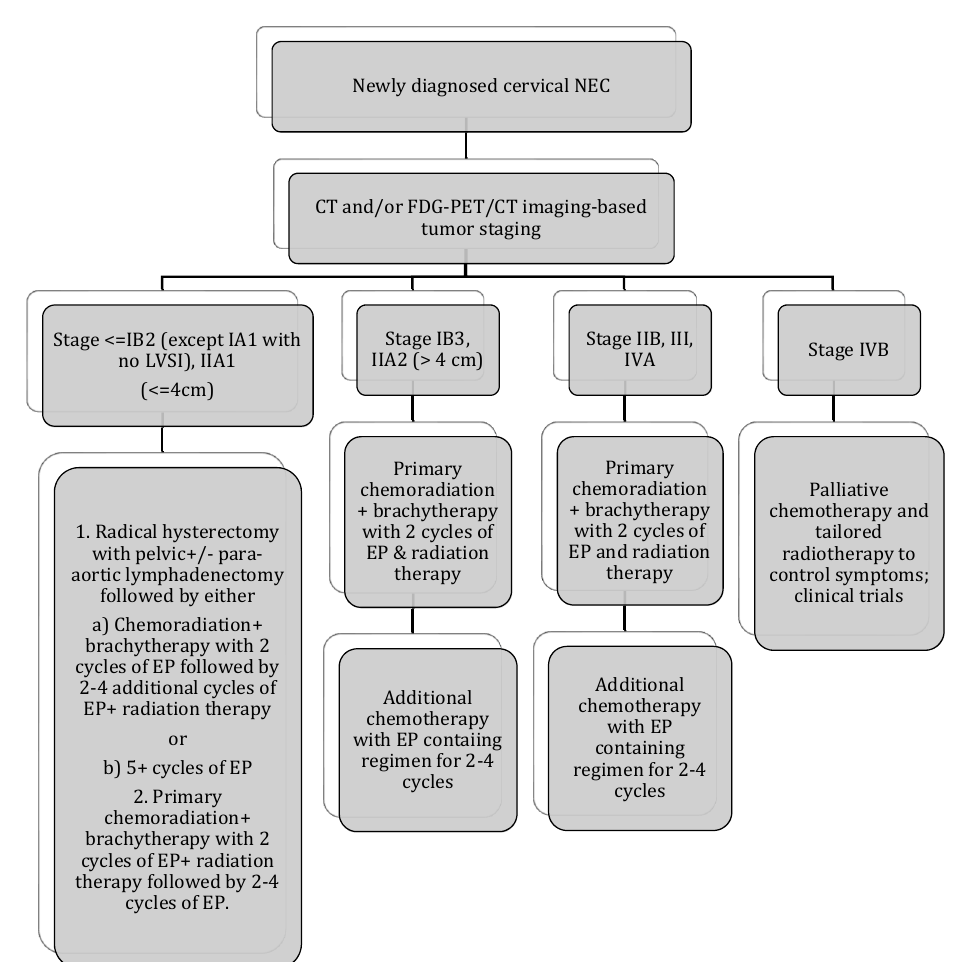
Figure 6. Stage-based treatment algorithm for cervical neuroendocrine carcinoma [2]. NEC: neuro- endocrine carcinoma; LVSI: lymphovascular space invasion; EP: etoposide and cisplatin; chemo-